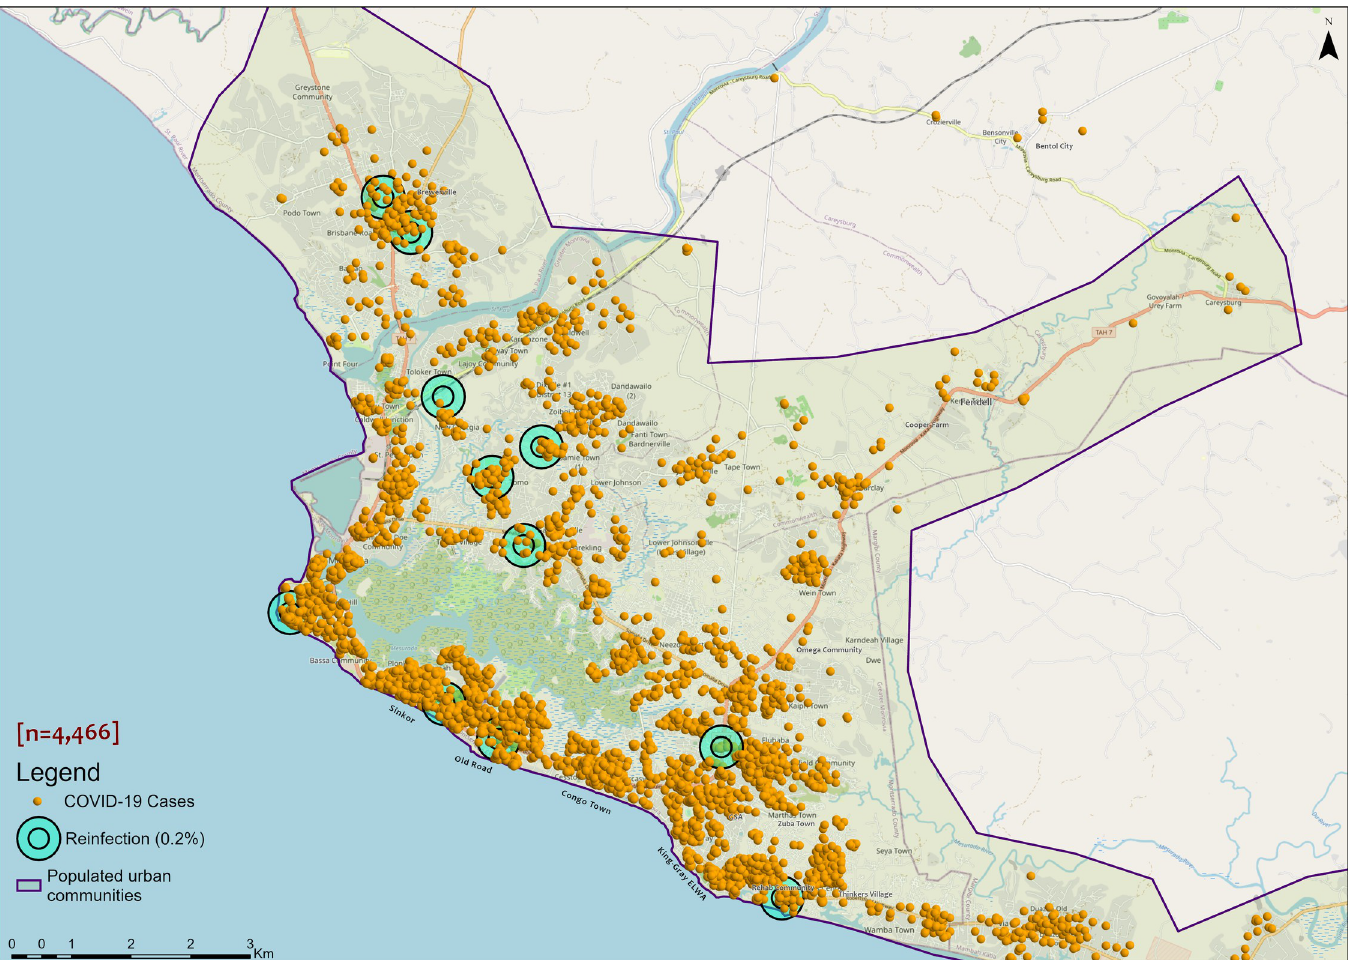
Fig 5. Distribution of COVID-19 cases in Montserrado communities, Liberia, March 15, 2020 to July 31, 2021. Data source: The Incident Management System for COVID-19 Response in Liberia (S2 File).